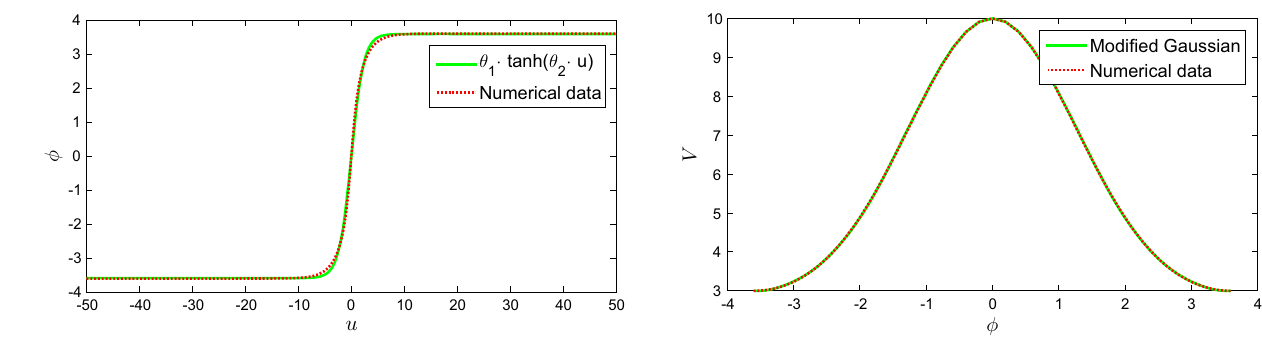
Fig. 6 Plot of φ( u ) obtained from its numerical solution as well as from the fit given by Eq. (35) for the values c = 0 . 5 and s = 1